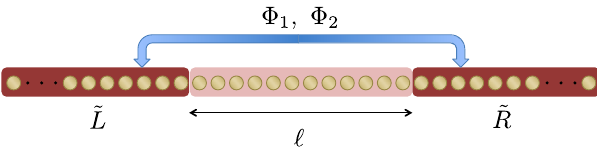
FIG. 6. The decomposition of the system in the Schmidt-rank